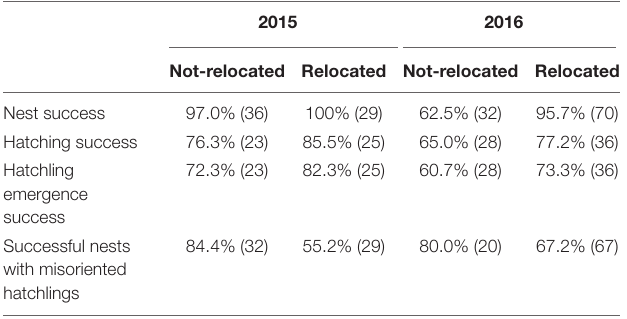
TABLE 2 | Nest relocation effects on loggerhead ( Caretta caretta ) nesting.